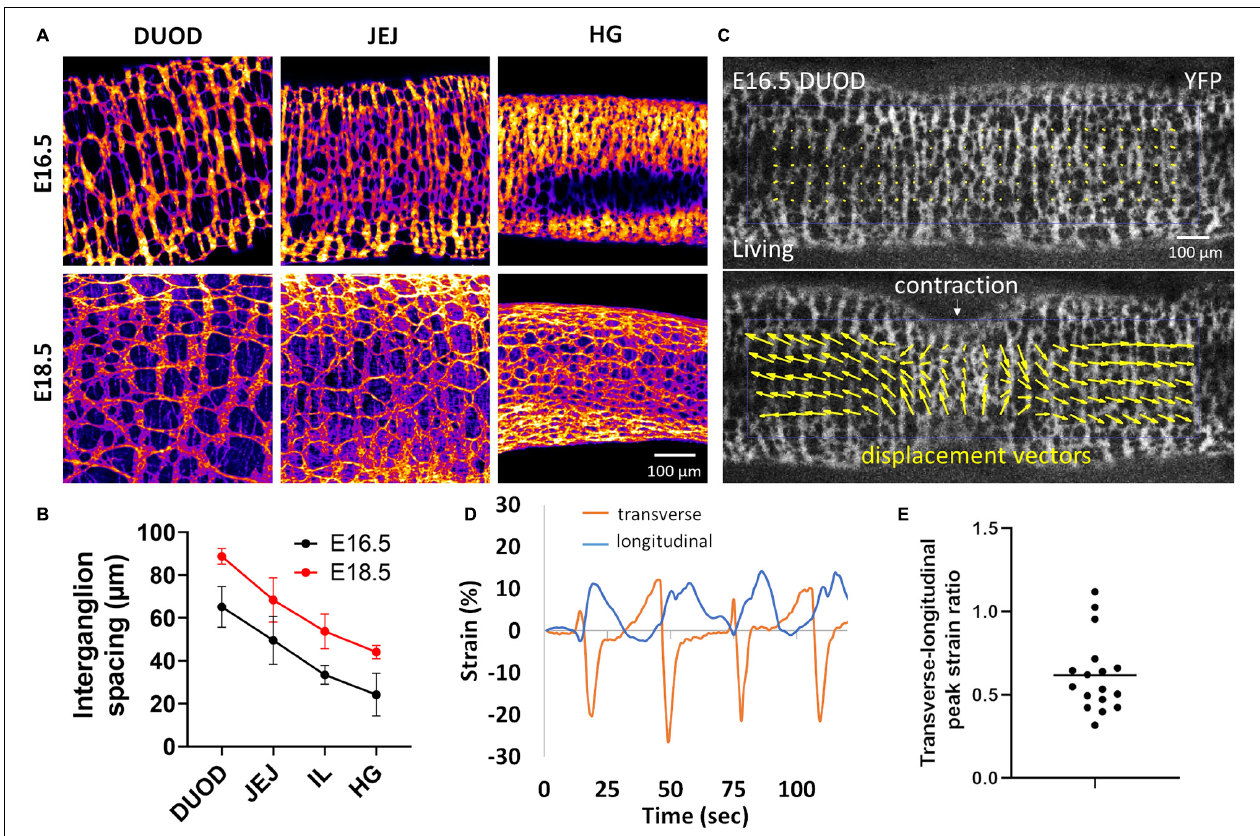
FIGURE 5 | Longitudinal stretch by circular contractions induces longitudinal spacing of enteric ganglia in the mouse. (A) Tuj1 immunostaining of the mouse ENS at E16.5 and E18.5 in the duodenum, jejunum and hindgut (HG). Ganglia are clearly seen to be more spaced apart in the longitudinal (horizontal) direction with increasing age. The scale bar of all panels is the same as in the bottom right corner. (B) Average inter-ganglion spacing, each dot is the average of the spacing measured for n = 4 embryos at each stage, error bar is ± SD. (C) Frame from Supplementary Video 4 in the relaxed state and during a CSM contraction, E16.5 mouse duodenum, lower panel: PIV map of displacement vectors. (D) Representative longitudinal and transverse strain measured by ganglion tracking of four successive contraction events. (E) Peak longitudinal over peak transverse strain ratio measured for 17 contractions from n = 4 E16.5